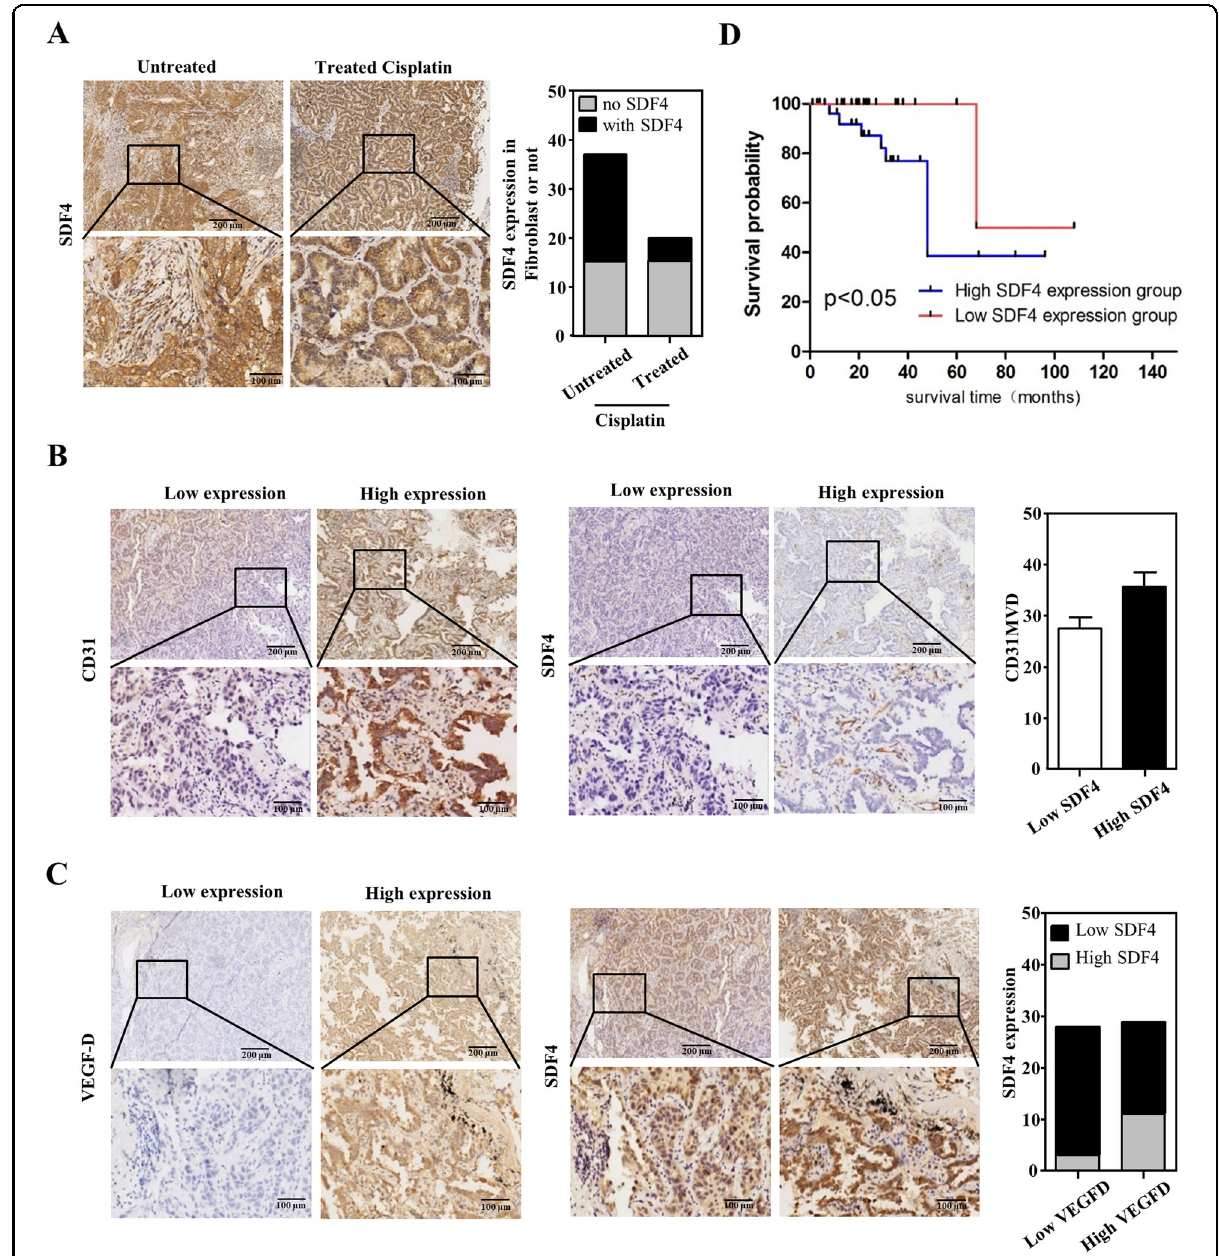
Fig. 6 SDF4 is positively correlated with VEGF-D and the endothelial cell marker CD31 expression and poor survival of lung cancer patients treated with cisplatin. A Tissue specimens from 57 patients with lung cancer treated with or without cisplatin were stained for SDF4 expression. SDF4 was positively correlated with fi broblasts in cisplatin-treated lung cancer patients. B , C SDF4, VEGF-D, and CD31 staining was performed via IHC with their individual speci fi c antibodies. SDF4 abundance was correlated with VEGF-D and CD31 signals in 57 lung cancer patients. D Correlation between SDF4 abundance and the survival rate of cisplatin-treated lung cancer patients. Differences between patient subsets in overall survival were determined via Kaplan – Meier plot analysis and log-rank tests. A two-tailed p < 0.05 was considered statistically signi fi cant. Statistical analysis was performed with SPSS v. 17.0 software (SPSS,